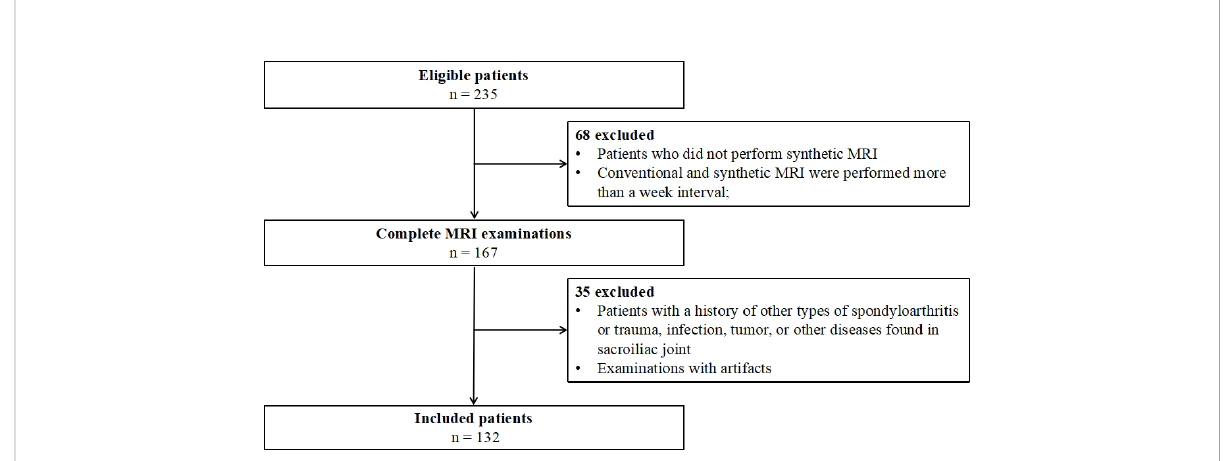
FIGURE 1 Flow diagram of study